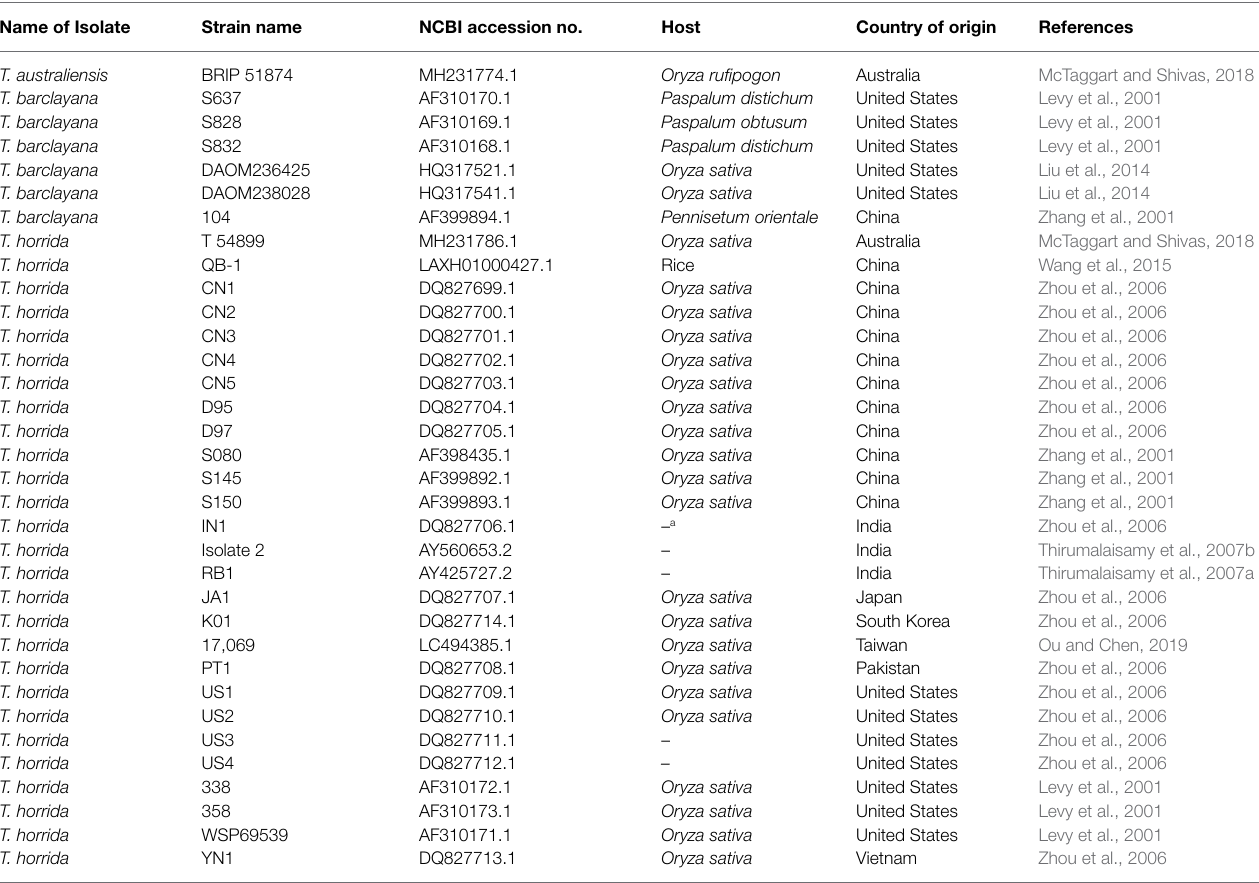
TABLE 3 | NCBI accession number, host, and country of origin of the strains of Tilletia australiensis, T. barclayana , and T. horrida used in the final ITS-only region phylogenetic